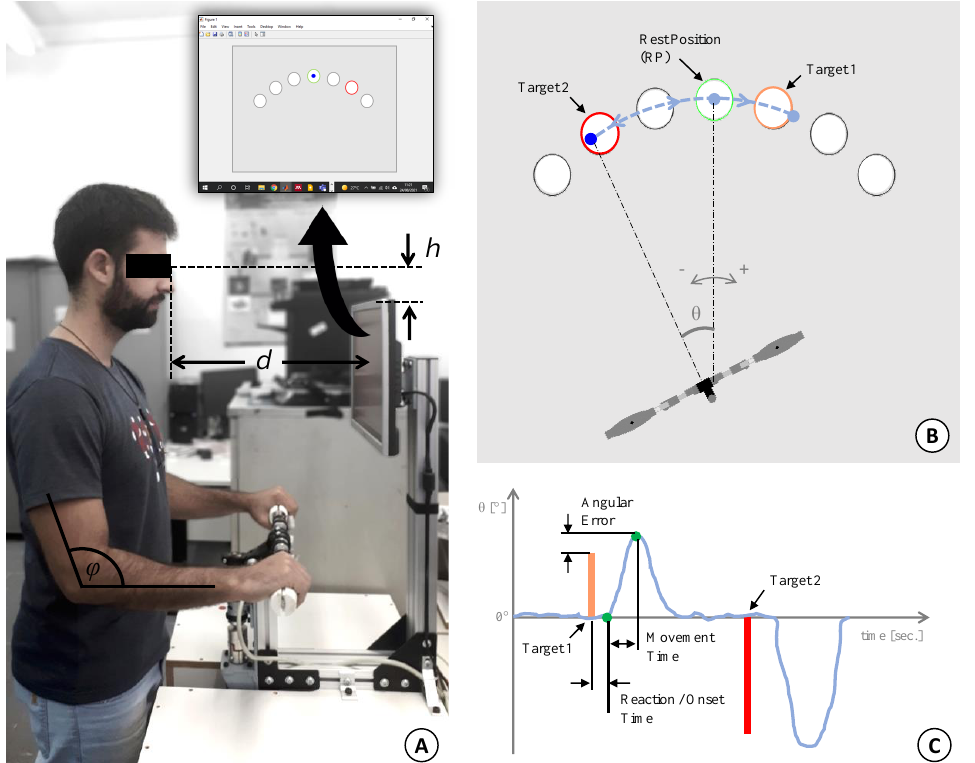
Figure 5. ( A ) The robotic handlebar during a healthy subject interaction. Before the experiment, the device was adjusted to each participant to respect the following ranges: − 30 mm < h < 30 mm, 400 mm < d < 450 mm e 60 ◦ < φ < 90 ◦ . The inset figure shows the graphical interface developed in MATLAB ® . ( B ) Illustration of the visual interface. The blue dot cursor is controlled by the user, and it goes through the centre of each circle. The trial target is the one with a red outline. ( C ) Performance parameters: spatial error (SpTE), reaction time (RT)/onset time (OT) and movement velocity (obtained through movement time, MT).